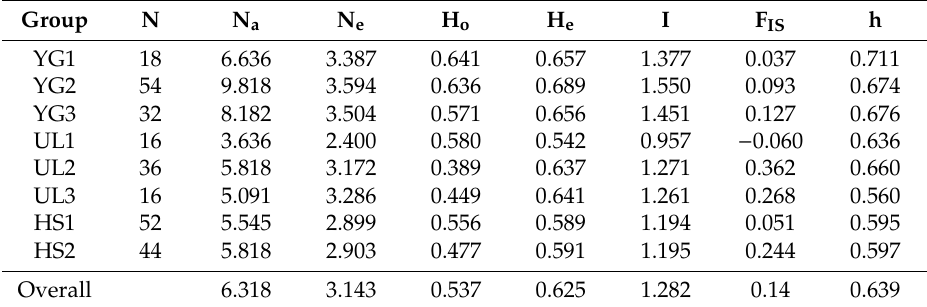
Table 1. Genetic diversity and diversity indices of 11 nuclear microsatellite loci estimated for eight sampling sites of the spring orchid ( Cymbidium goeringii Lindley).